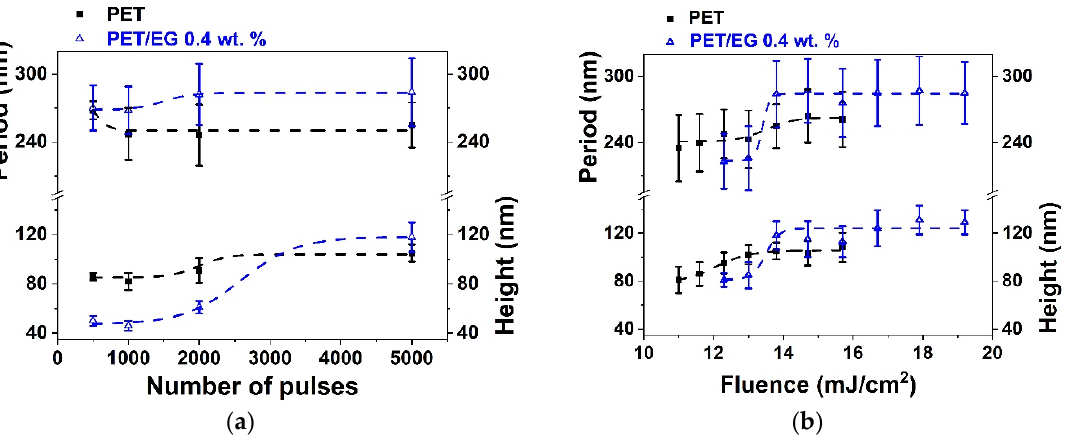
Figure 2. Heights and periods of LIPSS induced on thin films of PET ( ■ ) and PET/EG 0.4 wt.% ( Δ ) as a function of: ( a ) the number of pulses at a constant fluence of 13.8 mJ/cm 2 and ( b ) the fluence at a constant number of pulses of 5000. Laser irradiation was performed at a wavelength of 265 nm. Dotted lines are displayed as visual guides. The data shown correspond to the average and standard deviation of 50 measurements.